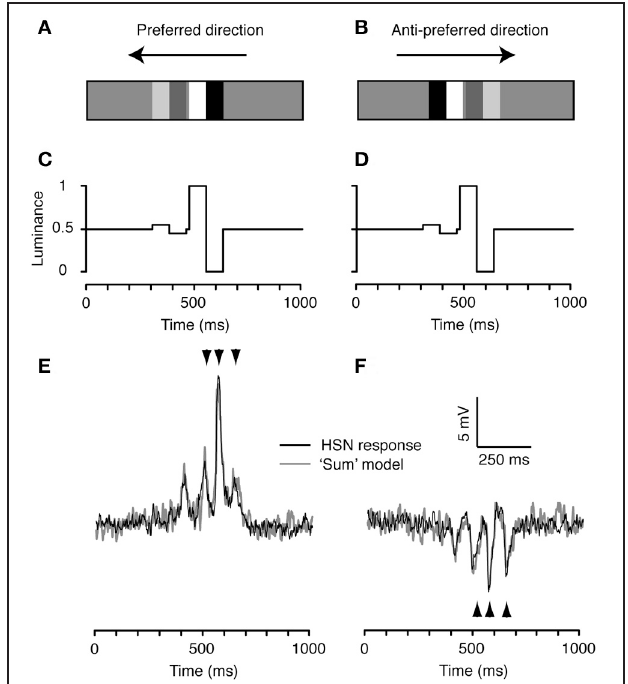
FIGURE 3 | The increasing contrast feature pair. (A) We combined the high and low contrast doublets to produce a pair where the low contrast (10%) doublet is followed by the high contrast doublet, referred to as the increasing contrast doublet pair. (B) The spatial arrangement is flipped for stimulation in the anti-preferred direction, so that the temporal order of doublet contrasts remains the same. (C) Time-luminance trace for motion in the preferred direction. (D) Time-luminance trace for motion in the anti-preferred direction. (E) Intracellular response of an HS neuron to the increasing contrast pair moving in the preferred direction. The gray line indicates the predicted response based on the linear sum of the response to each individual doublet (as in Figure 2 ). The arrowheads highlight the timing of the three peaks to the second doublet, predicted from the model output (see Figure 2 ). (F) HS response to the doublet pair moving in the anti-preferred direction. The gray line indicates the linear sum of the response to the individual doublets (see Figure 2 ). The arrowheads highlight the timing of the three peaks to the second doublet, predicted from the model output. n = 20 from the same neuron as shown in Figures 2 and 4